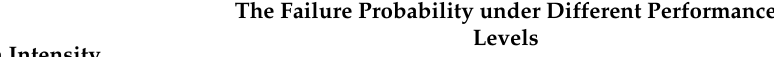
Table 5. Vulnerability